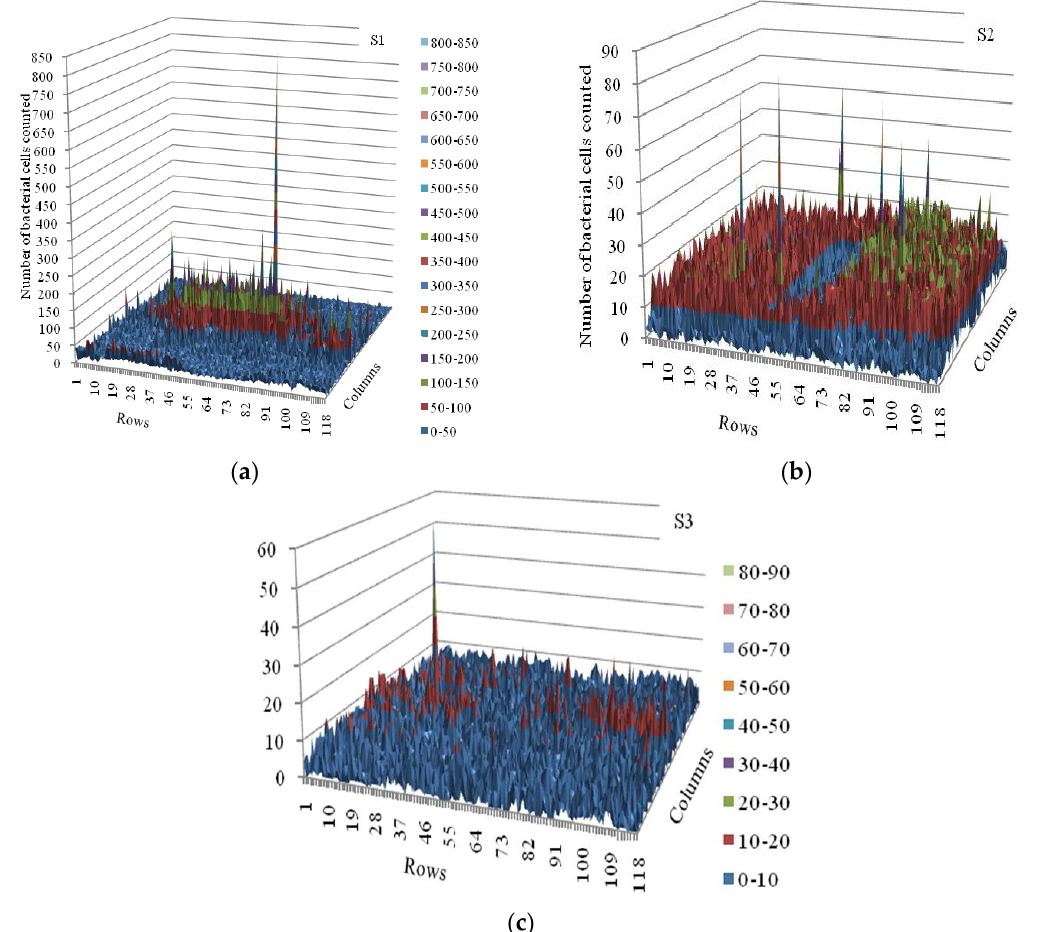
Figure 4. Spatial distribution of bacterial cells under the cover slip for samples, ( a ) S1, ( b ) S2 and ( c ) S3 are shown using three-dimensional surface plots based on the respective count matrices. In each plot, the number of bacterial cells is shown along the z -axis, rows of the count matrix along the y -axis and columns of the count matrix along the x -axis.